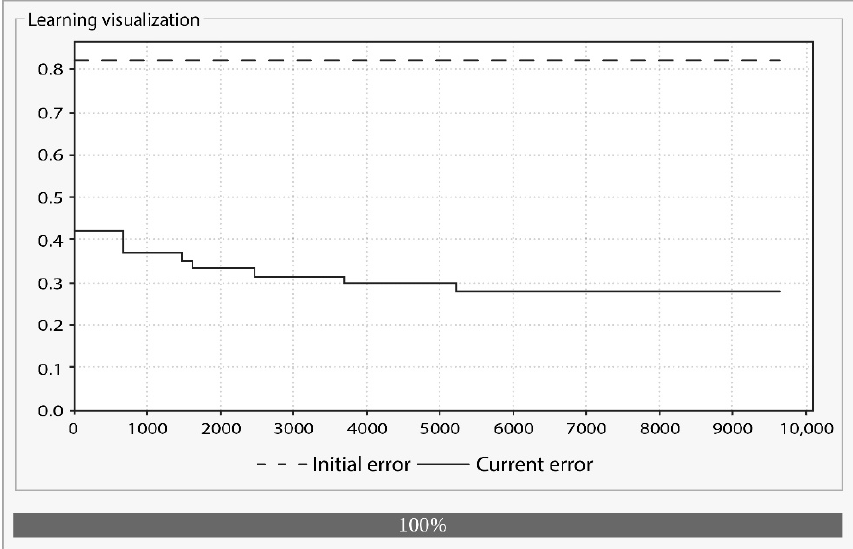
Figure 6. Visualization of error curve in the process of finding the optimal weight matrix.